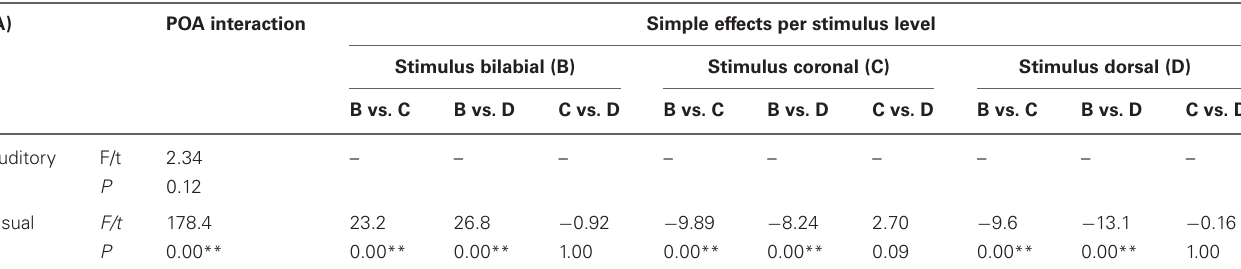
Table 1 | Results for the POA analyses of the unimodal